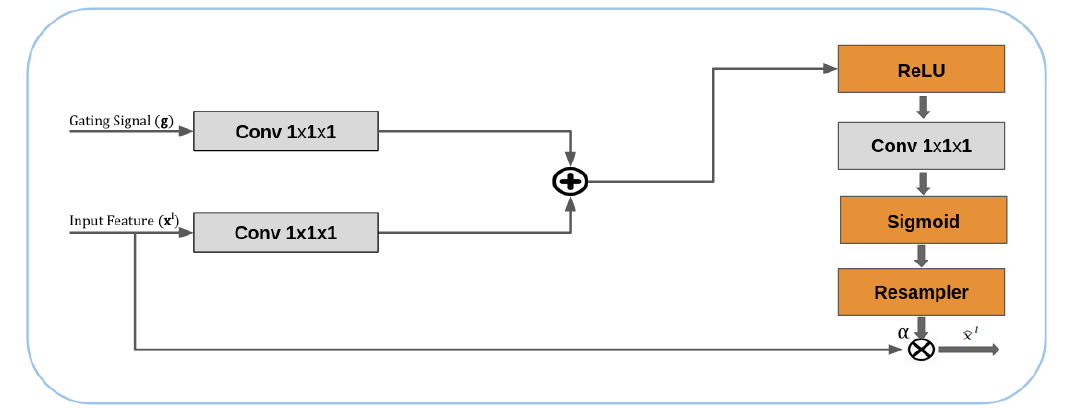
Figure 2. Schematic of attention gates